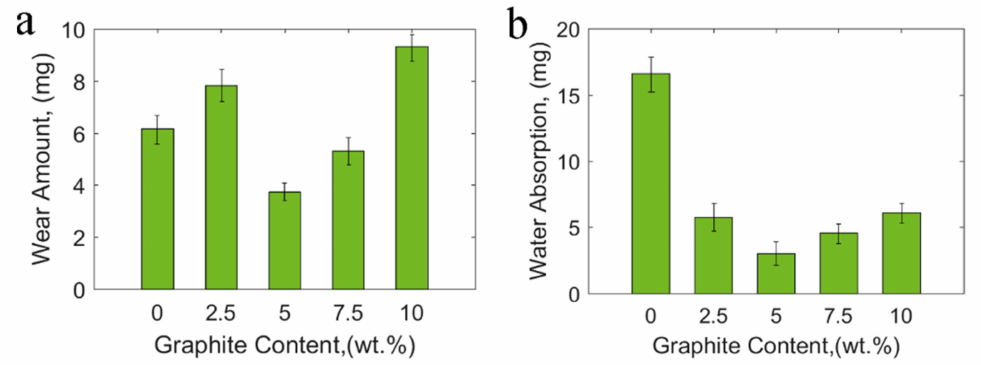
Figure 6. ( a ) Water-lubricated wear amount and ( b ) water absorption after soaking 24 h with different graphite